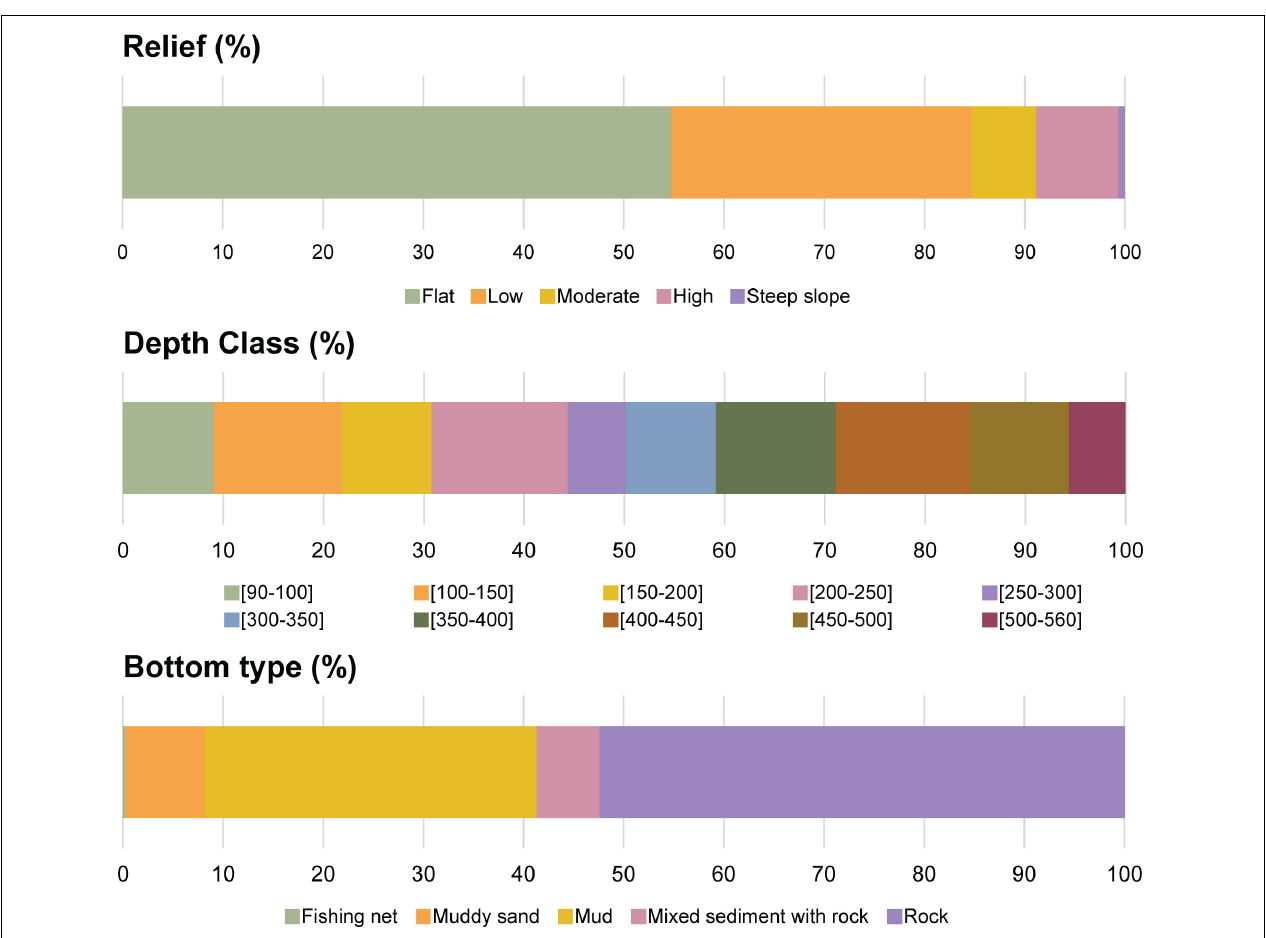
FIGURE 2 | Percentage contribution of the relief, depth class and bottom type (substratum) categories in the surveyed area of the São Vicente